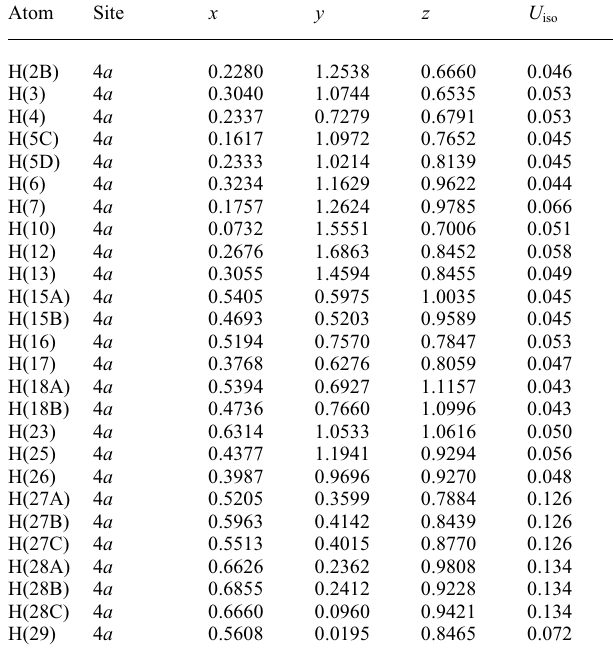
Table 1. Data collection and